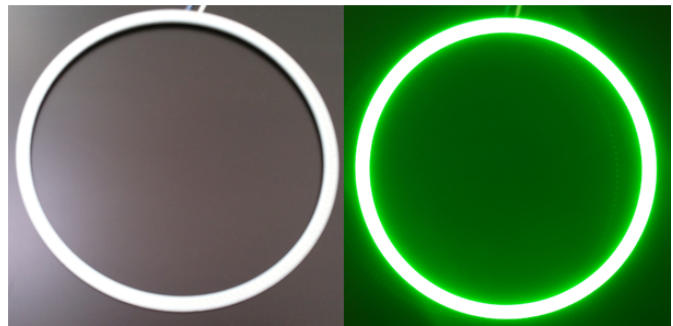
Figure 3. The chip-on-board radial LED unlit ( left ) and lit ( right ).